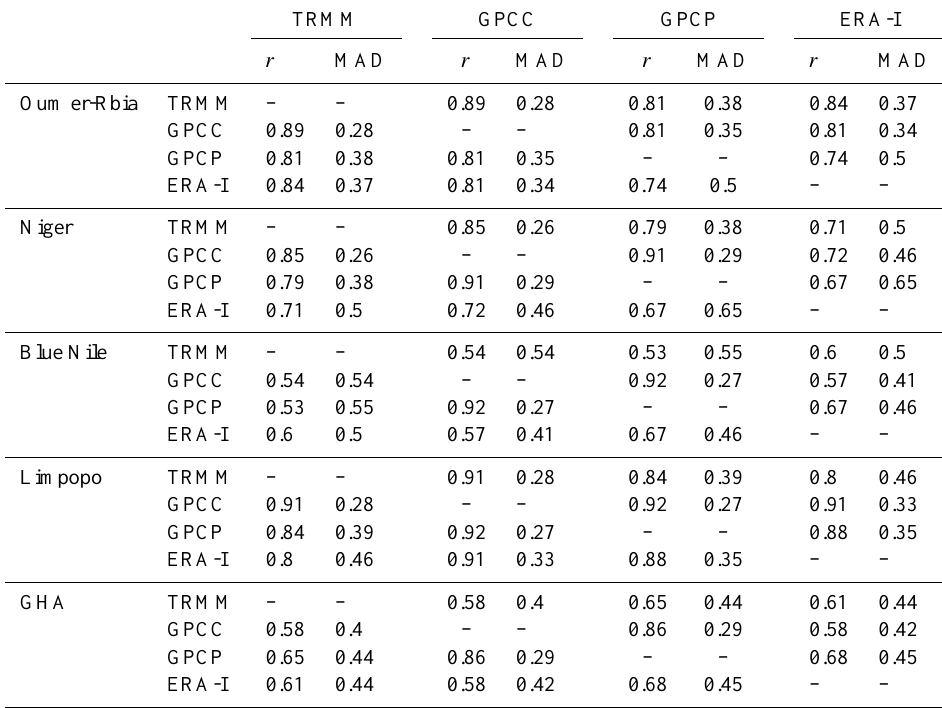
Table 4. Spearman correlation coefficient ( r ) and mean absolute difference (MAD) between the different SPI-3 estimations averaged over each region for the common period